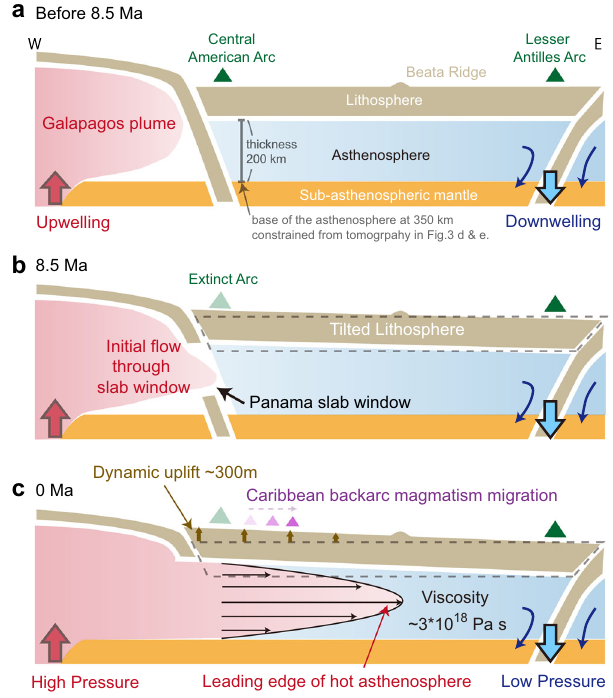
Fig. 5 Time-evolution cartoon of Caribbean asthenosphere and dynamic topography. Hotter asthenosphere sourced from the Galapagos plume fl owed eastwards through the Central America slab window towards the Caribbean and produced an eastward dynamic tilt of the Earth ’ s surface. a At 8.5 Ma, prior to the slab window opening, the regional upper mantle was segmented by subducted slabs. b At ~8.5 Ma, the opening of the Panama slab window allowed eastward asthenospheric fl ows that were driven by pressure differences between the upwelling Galapagos plume to the west, and the subduction downwelling to the east. This geological event terminated the arc at the Panama land bridge and began the dynamic uplift of the Caribbean. c At present, the leading edge of hot asthenosphere imaged by full-waveform tomography 25 has reached the Beata ridge. Eastward propagation of hot asthenosphere across the region produced time-transgressive back-arc magmatism within Central America that has a clear Galapagos isotopic signature 26 . Integration of these space-time constraints allows us to obtain the fl ow velocity of the Galapagos hot pressure gradient and the thickness of the asthenosphere, constrain the absolute viscosity of the asthenosphere under the Caribbean to ~3*10